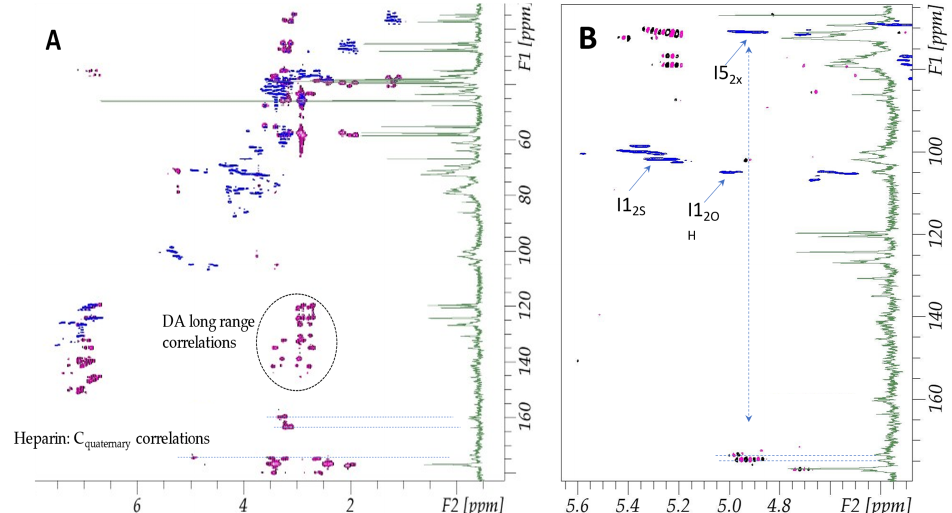
Figure 1. Total ( A ) and partial ( B ) HSQC spectra of purification intermediates of DA-LMWH (blue) superimposed on a heteronuclear multiple-bond correlation spectrum (HMBC, pink) and on a 13 C spectrum (green) projection.